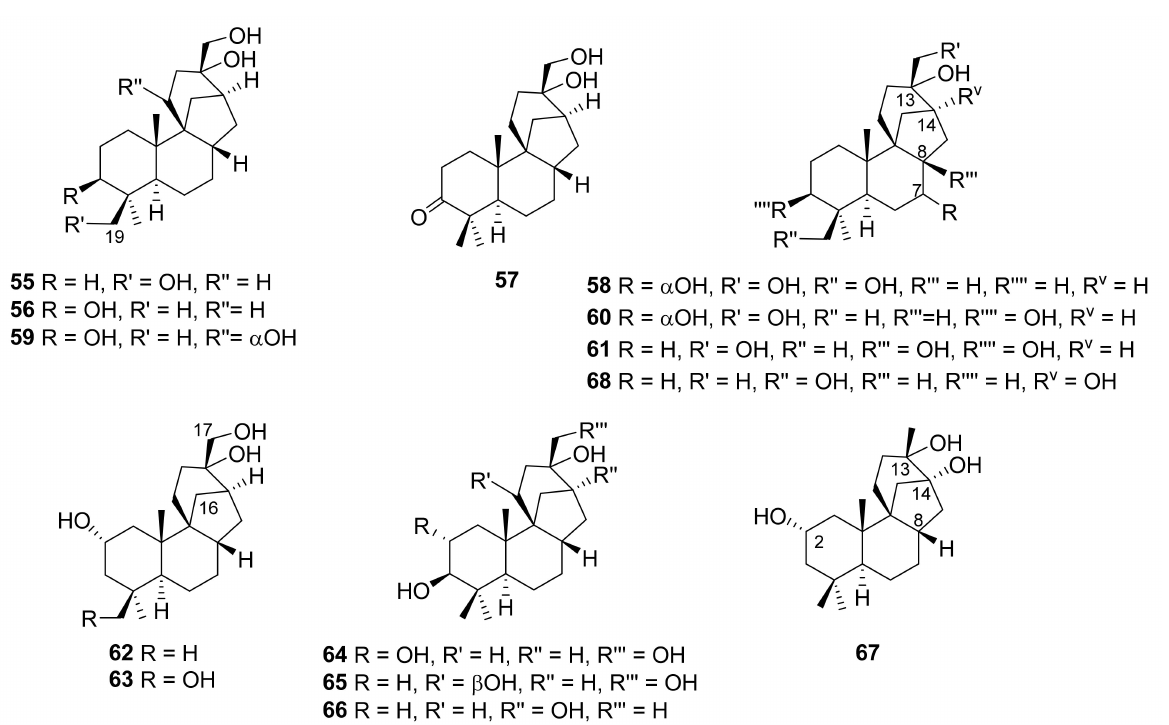
Figure 13. Stemodane diterpenoids biotransformation